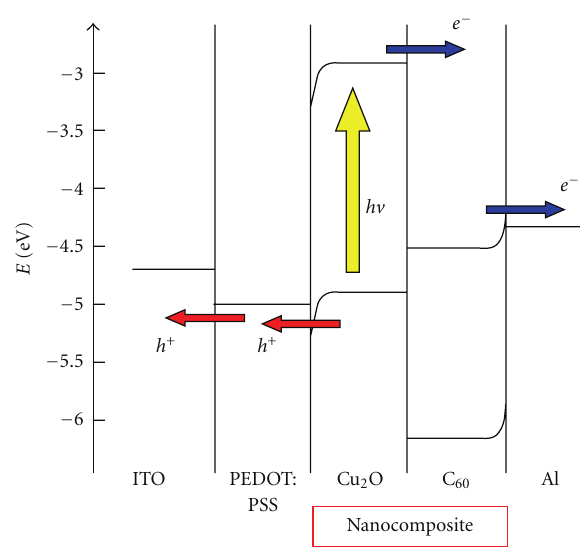
Figure 13: Energy level diagram of ITO/PEDOT:PSS/Cu 2 O:C 60 /Al bulk heterojunction solar